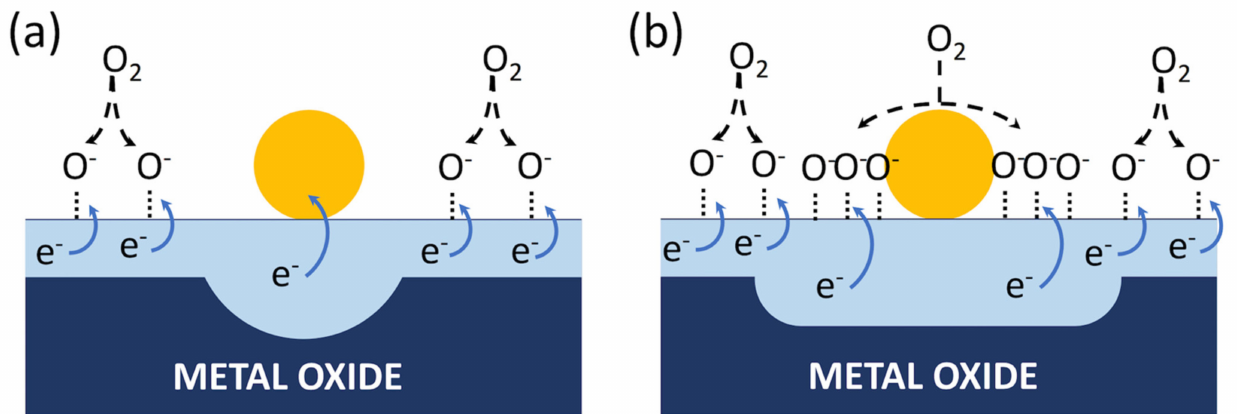
Figure 6. Schematic representation of metal oxide sensitization by means of metallic nanoparticles. ( a ) Electronic sensitization: the depletion layer is extended at the metal–metal oxide interface as a consequence of Fermi level alignment between the two materials; ( b ) spillover of oxygen molecules, O 2 , promoted by the metallic nanoparticle: oxygen molecules from the gas phase are dissociated by the metallic nanoparticle and further chemisorbed over the metal oxide surface. In the surrounding of the nanoparticle, this causes both an increase in the density of active ions and an extended depletion